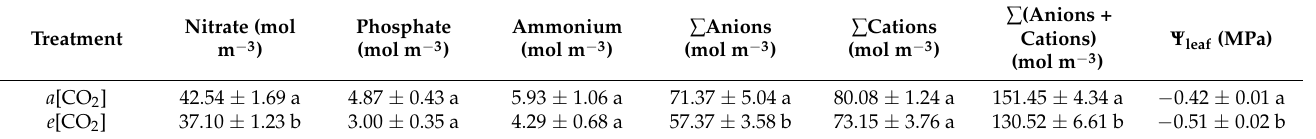
Table 2. Xylem sap constituents and leaf water potential ( Ψ leaf ) of Phragmites australis grown under ambient ( a [CO 2 ], 400 ppm) and elevated ( e [CO 2 ], 800 ppm) atmospheric CO 2 concentrations. Different small letters mean significant difference at p < 0.05 level. Data are expressed as means ± SEM (n = 3).